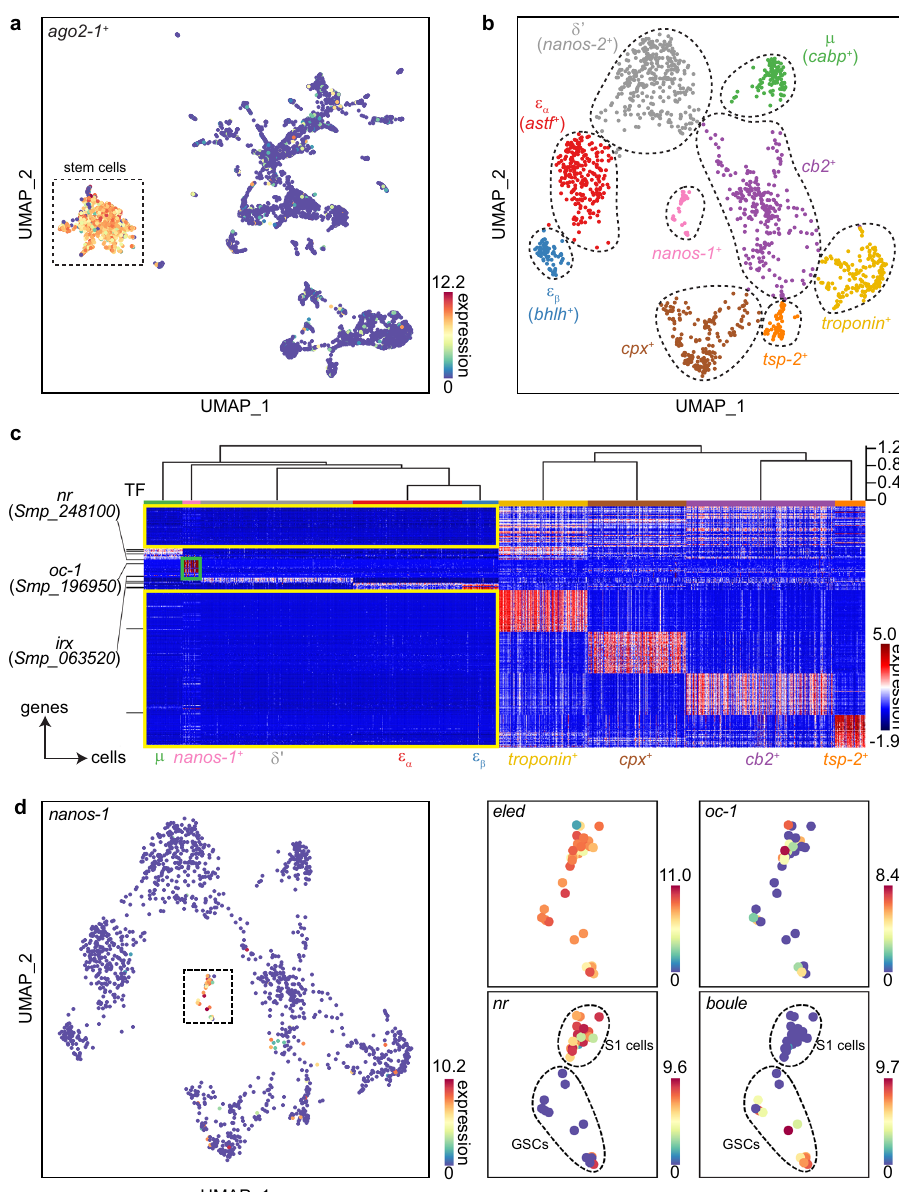
Fig. 1 scRNA-seq identi fi es schistosome stem cell subpopulations and GSC transcriptional signatures. UMAP projections showing scRNA-seq data of a all cells and b ago2-1 + stem cells (boxed in a ) only. The manifolds are reconstructed by SAM 25 . In a , ago2-1 expression is overlaid. In b , cells are color- coded by Leiden clusters and annotated based on marker gene expression. c Heatmap showing the expression of genes enriched in speci fi c stem cell populations, with the mean expression of each gene shifted to 0. Top: the populations are grouped through hierarchical clustering in the PC space, with the height of the branches representing correlation distance between populations. Left: annotated transcription factors (GO: 0003677 DNA binding and GO: 0003700 DNA-binding transcription factor activity) are indicated by black lines. Yellow boxes: genes that lack expression in the presumptive multipotent group compared to the progenitor group. Green box: genes enriched in nanos-1 + population. For the sake of visualization, we only show the top 50 markers per cluster. The complete list of markers is provided in Supplementary Data 1. d UMAP projections showing the expression of nanos-1 in stem cells (left) and the expression of eled (a previously characterized GSC marker 5 ), oc-1 , nr , and boule in nanos-1 + cells (right). nr and boule expression separate nanos-1 + cells into S1 stem cells and